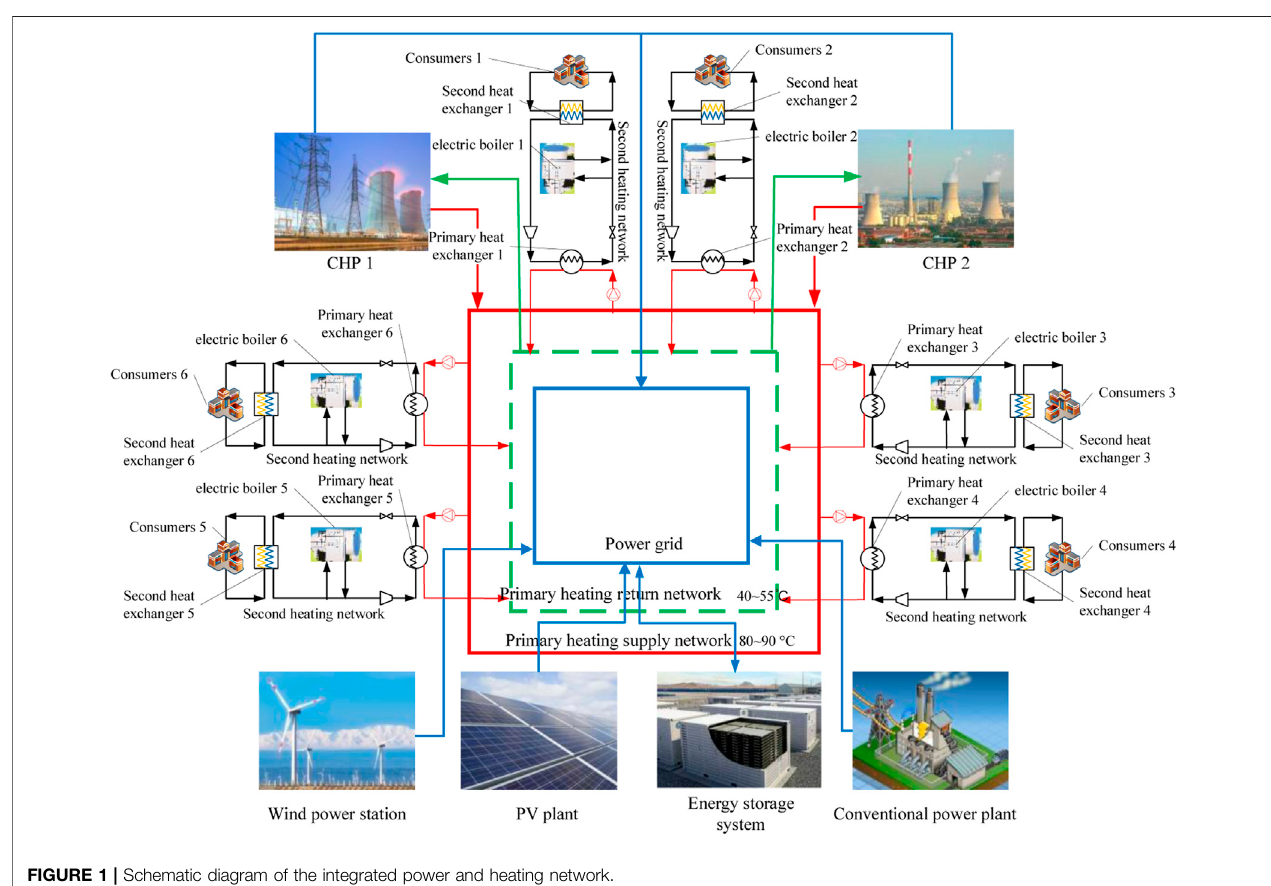
FIGURE 1 | Schematic diagram of the integrated power and heating network.